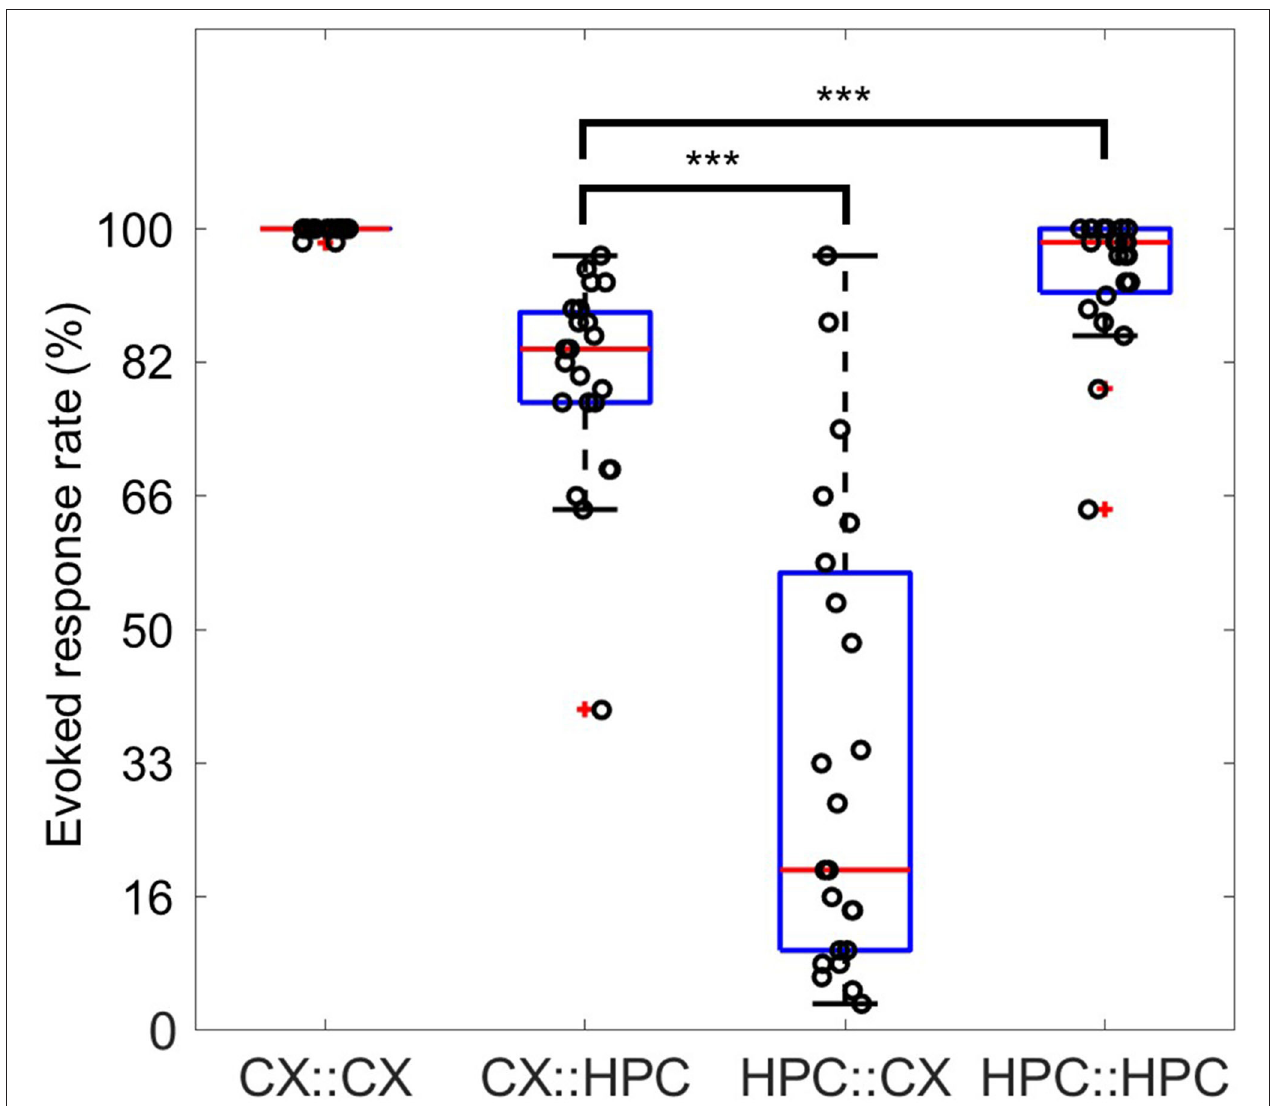
FIGURE 9 | Response rates for direct network stimulation and cross-chamber evoked responses. Four possibilities for evoking a response are illustrated. The response rate of X to stimulation in Y is expressed as Y::X. The direct response of the CX network to stimulation in the CX network is expressed as CX::CX, whereas the response of the HPC network to stimulation in the CX network is expressed as CX::HPC. Each data point displays the rate of observation of evoked responses possessing sufficient firing activity within 500ms after stimulation. The direct evoked response in both CX::CX (0.9986 ± 0.0048) and HPC::HPC (0.9435 ± 0.0828) showed a response rate > 90%. The cross-chamber response CX::HPC (0.8123 ± 0.1263) shows a rate around 80%. However, over half of the samples show a response rate lower than 50% in the reverse direction, HPC::CX. The direct evoked response in HPC::HPC is significantly greater than the cross-chamber response in CX::HPC (***, P < 0.0001, Mann–Whitney U-test). The cross-chamber evoked response in CX::HPC is significantly greater than the cross-chamber response in HPC::CX (***, P < 0.0001, Mann–Whitney U-test).